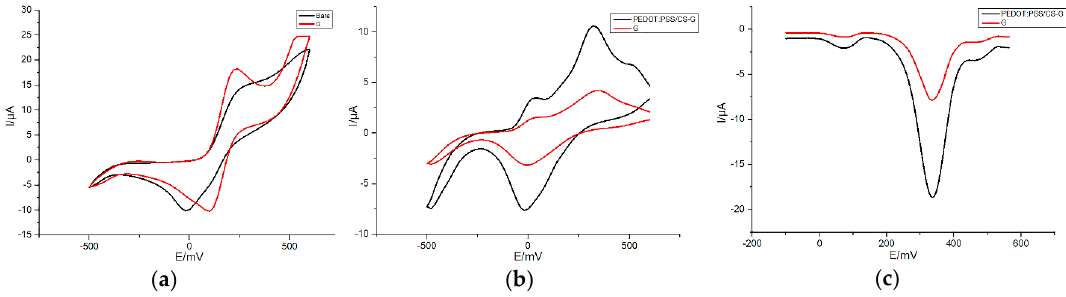
Figure 3. ( a ) Cyclic voltammetry (CV) of 50 µ M K 3 [Fe(CN) 6 ] in 0.1-M PBS (pH: 7.4, 0.1-M KCl) at bare and modified screen-printed electrode (SPE) (G / SPE); ( b ) CVs of 20 µ M dopamine (DA), 20 µ M ascorbic acid (AA) and 20 µ M uric acid (UA) in 0.1-M phosphate bu ff er solutions (PBS) (PH: 7.4, 0.1-M KCl) at poly(3,4-ethylenedioxythiophene) (PEDOT):PSS / CS–G / SPE and G / SPE; ( c ) di ff erential pulse voltammetry (DPV) responses of 30 µ M DA, 30 µ M AA and 30 µ M UA in 0.1-M PBS (pH: 7.4, 0.1-M KCl) at PEDOT:PSS / CS–G / SPE and G / SPE. Detection parameters: CV—potential range from − 500 to + 600 mV, 50 mV / s scan rate; DPV—potential range from − 100 to + 560 mV, 50-mV pulse amplitude, 2-mV step potential, 0.05-s pulse